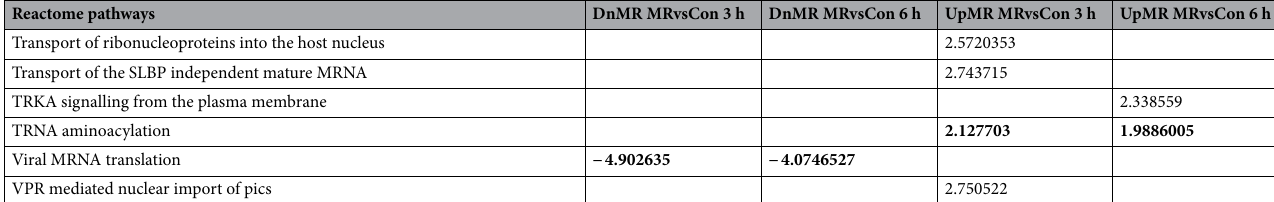
Table 1. Significantly up/down-regulated Reactome pathways in MR at 3 h, 6 h. Reactome pathways that are significantly (FDR < 5%) up- or down-regulated in MR at 3 h and 6 h were identified via GSEA pre-ranked.